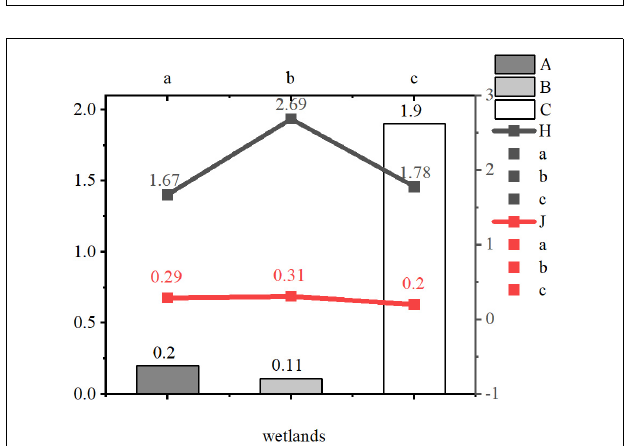
FIGURE 10 | (a): “H” is the Shannon Wiener index of birds in 2019. “J” is the Pielou uniformity index of birds in 2019. “a”: Haihu wetland. “b”: Beichuan wetland. “c”: Ninghu wetland. “A”: Increase rate of wild bird species in 2018-2019. “B”: Increase rate of waterfowl in 2018-2019. “C”: Increase rate of waterfowl in 2018-2019.